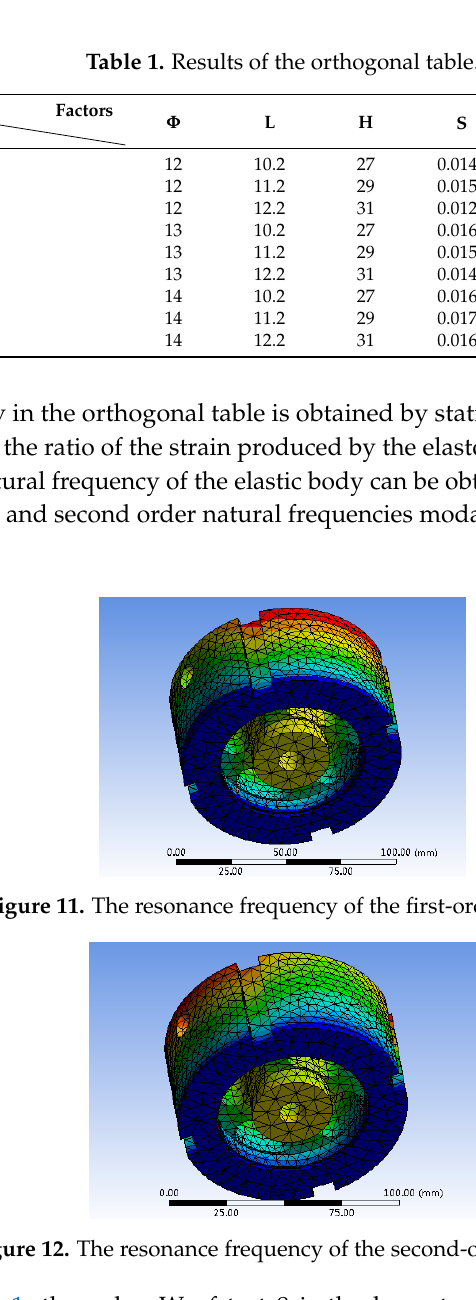
Table 1. Results of the orthogonal table.